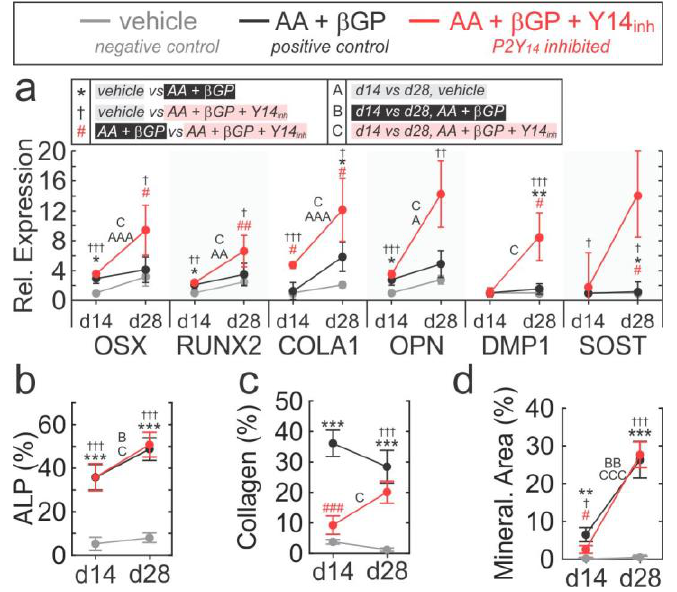
Figure 5. Role of P2Y 14 in osteogenic di ff erentiation. Bone marrow-derived cells were cultured with or without osteogenic factors (50 µ g / mL ascorbic acid, AA; 2 mM β -glycerol phosphate, β GP) and 100 nM PPTN (Y14 inh ) and osteogenic phenotype was evaluated at days 14 and 28. ( a ) Top : description of symbols representing specific comparisons; the level of significance is indicated by single ( p < 0.05), double ( p < 0.01) or triple ( p < 0.001) symbols. Bottom : gene expression of osteogenic markers assessed by RT-PCR at days 14 and 28 post-osteogenic induction. Data means ± sem, normalized to d14 vehicle condition; n = 5 independent cultures. ( b , c ) Cultures were fixed and stained for alkaline phosphatase ( b ; ALP), collagen ( c ; Sirius red stain) and mineralization ( d ; alizarin red stain). Stained cultures were visualized by brightfield microscopy, and surface coverage (%) was quantified; n = 5 independent cultures, with 2–5 fields of view quantified per culture.